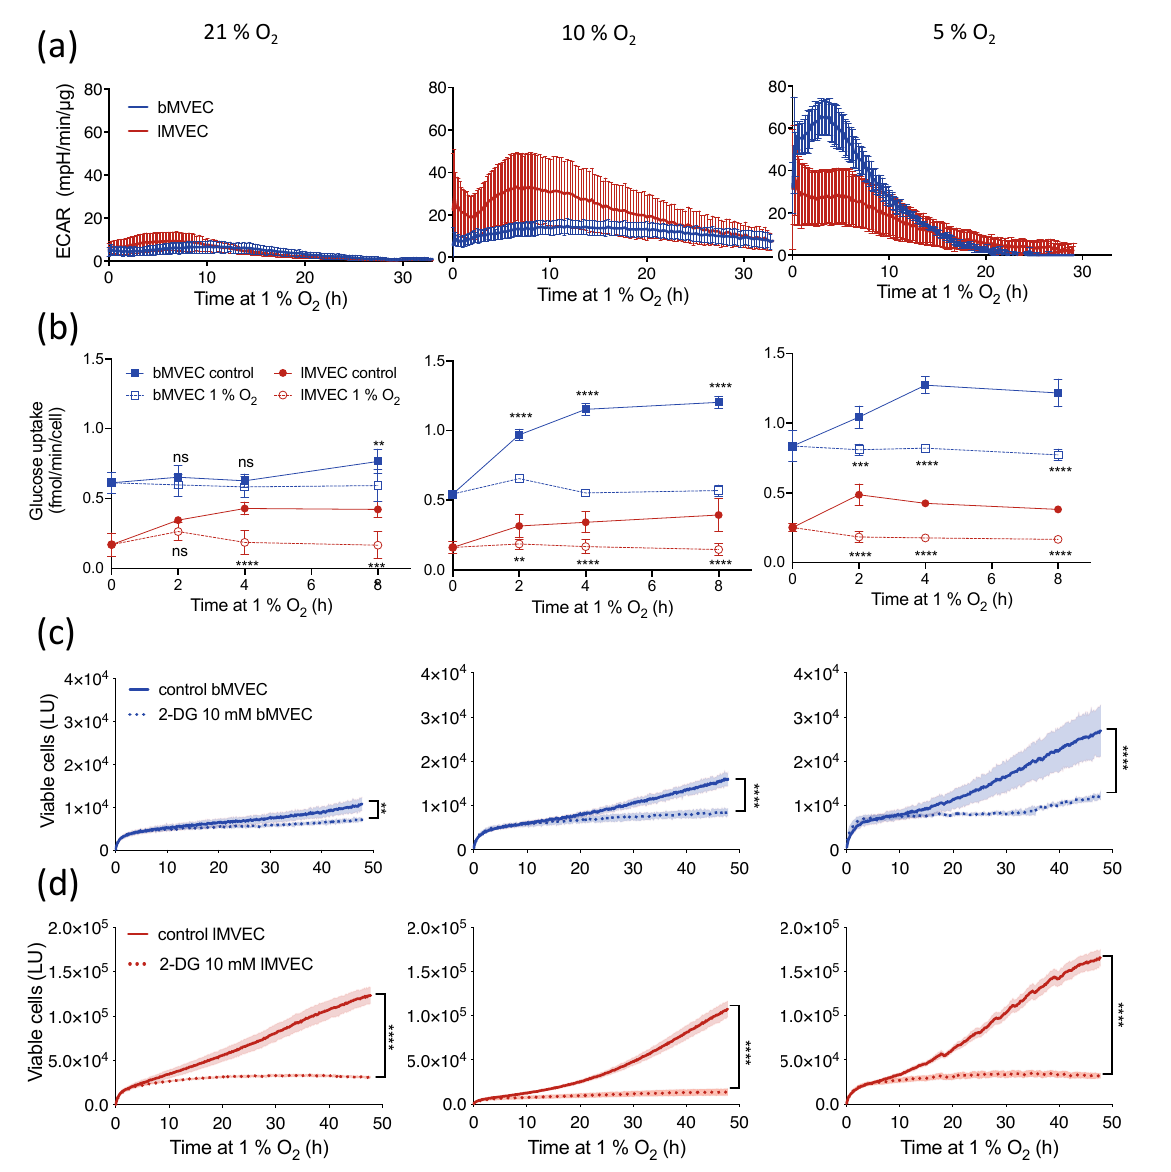
Figure 4. Timing and amplitude of metabolic shift to glycolysis is organ-specific and oxygen- dependent. ( a ) Representative charts of real-time measurement of ECAR changes upon transfer to 1% O 2 at t = 0, in lung and brain MVEC previously expanded at different O 2 levels (21% O 2 , left), 10% O 2, middle or 5% O 2 , right) ( n ≥ 4); ( b ) glucose uptake in MVEC expanded at different O 2 levels at baseline (dashed line) or under hypoxia (solid line), was measured at the indicated times using the Glucose Uptake-Glo Assay (Promega). Data shown as average ± SD, and statistical differences were assessed by 2-way ANOVA with Holm–Sidak’s multiple comparison test (** p < 0.01, *** p < 0.001, **** p < 0.0001), n = 3; Real-time viability of ( c ) brain and ( d ) lung MVEC was assessed every 10 min using a Real-Time Glo Assay (Promega) in MVEC transferred to 1% O 2 at t = 0 and treated with 10 mM 2-deoxy glucose (dotted line) or PBS vehicle control (solid line). n = 6 for each condition. Shaded areas show SD, statistical differences were assessed by unpaired Student’s t-test, corrected for multiple comparisons (Holm–Sidak) using the area under the curve (** p < 0.01, **** p < 0.0001). Mitochondrial respiration parameters were assessed again but following adaptation to hypoxia (after 24 h at 1% O 2 ). Similarly to what was seen at baseline (prior to hypoxia), basal respiration rates were identical between the two MVEC populations primed at 21% O 2 (Figure 5c,d, left). Maximal respiration was seen to decrease only in l MVEC,